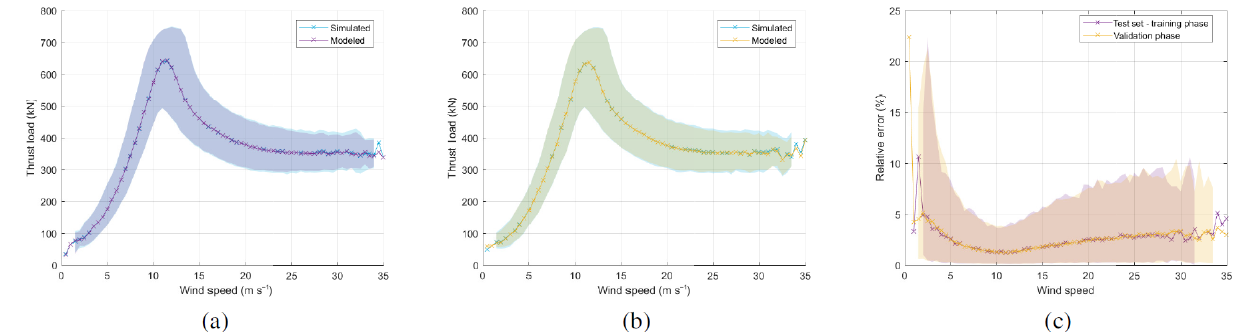
Figure 4. Modeled and simulated thrust loads for the total dataset during the training phase (training, validation and test set combined, simulated time of 2.5 days) (a) and the total dataset during the validation phase (1.5 days) (b) . The relative error (c) for the test dataset during the training phase and the additional dataset during the validation phase (simulated time of 1.5 days) is shown as well. The lines indicate median values for every wind speed bin of 0.5ms − 1 ; the surface spans from the 5th to the 95th percentile of the data.